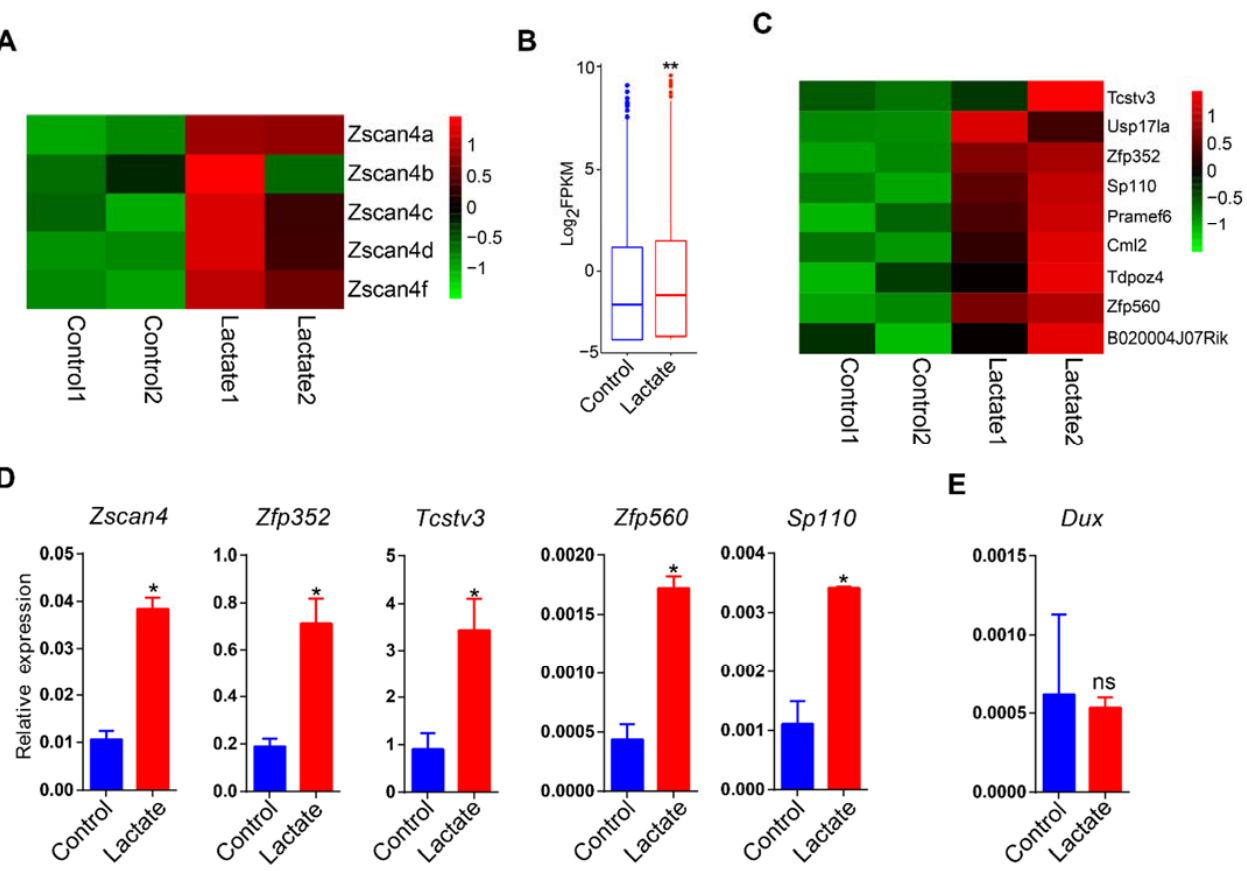
Figure 3. Lactate supplementation promoted expression of ZGA genes in mouse ESCs. ( A ) A heatmap of expression of Zscan4 family genes. ( B ) Global expression comparison of upregulated genes in MERVL + Zscan4 + ESCs between control and lactate-supplemented mouse ESCs. The Wilcoxon rank sum test was used to calculate p -values. ** p < 0.01. ( C ) Heatmap of representative upregulated ZGA genes. qRT-PCR analysis of ZGA genes ( D ) and Dux gene ( E ) in control and lactate-supplemented mouse ESCs. Data are presented as means ± SD ( n = 3); * p < 0.05; ns, p >0.05. Student’s t -test was used to calculate p values. Actb was used as the internal control.